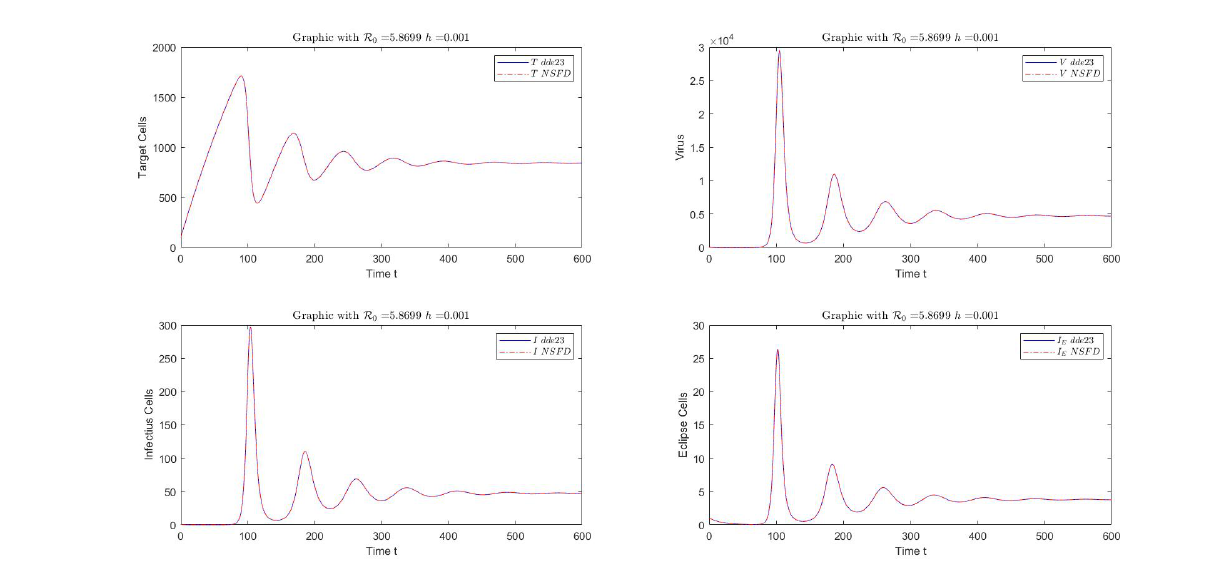
Figure 3. Simulation NSFD versus dde23 when R 0 >